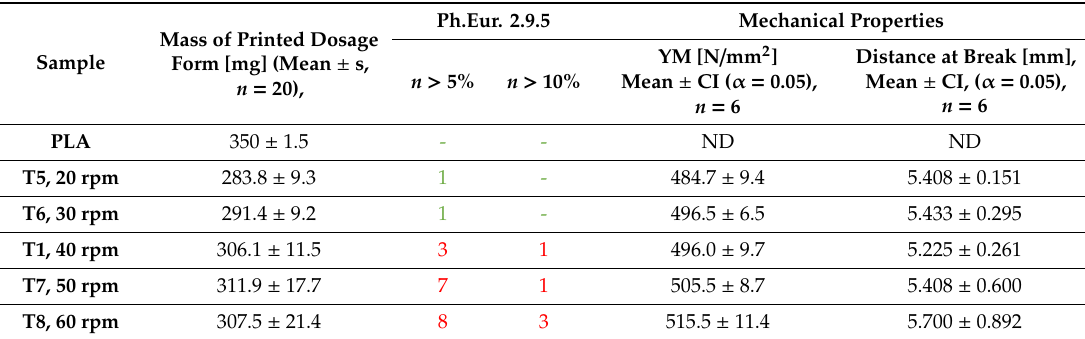
Table 3. Overview of the impact of diameter variations (related to applied screw speeds) on mechanical resilience of filaments and mass uniformity of printed test geometries, as well as results according to Ph.Eur. 2.9.5 (green numbers = corresponded; red numbers = not corresponded; ND = not determined).